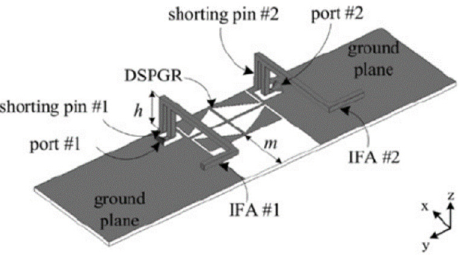
Figure 3. Diamond-shaped patterned ground resonator